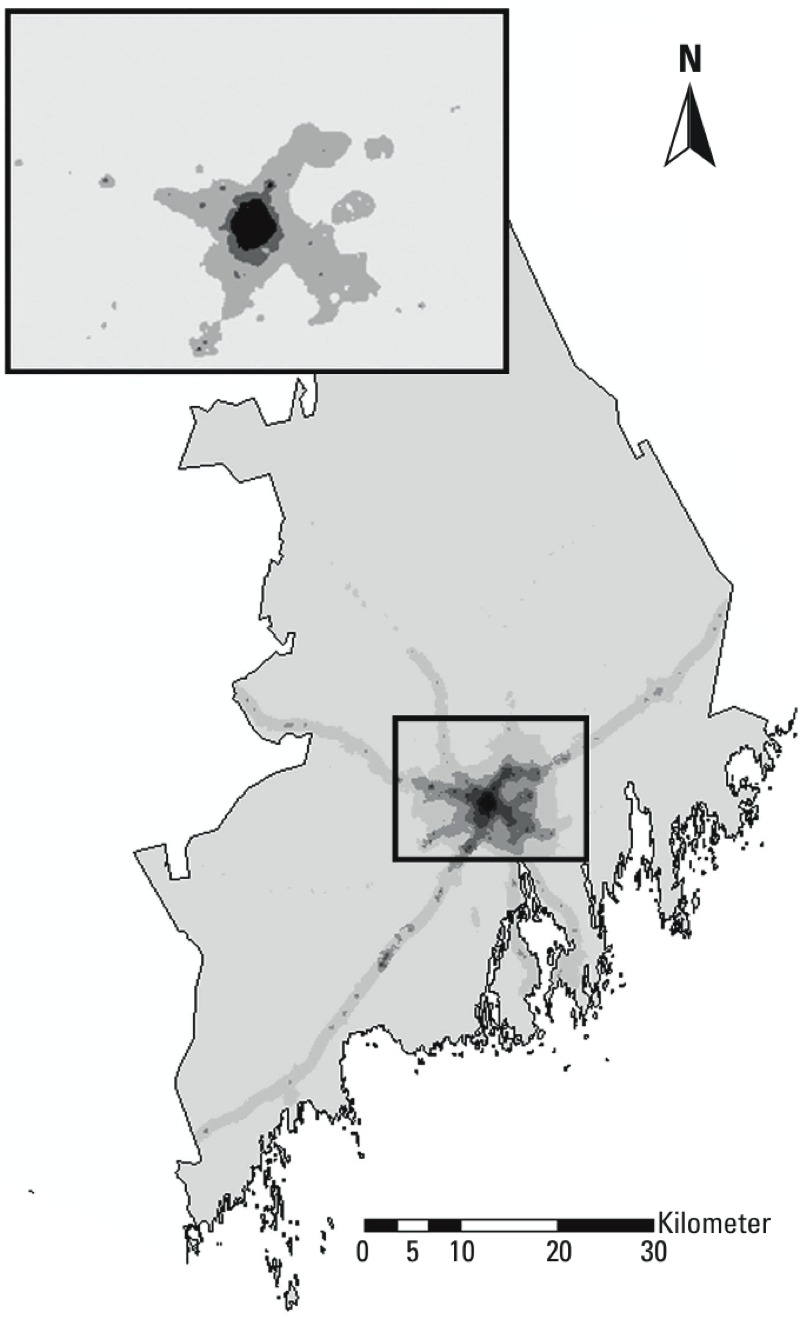
The study area of Umeå municipality illustrated with gradients of annual mean NOx concentration at the particpants’ home addresses at baseline. The lines of higher exposure radiating out from the central area (Umeå city center) correspond to major roads in the area. The smaller map shows the borders between the quartiles.